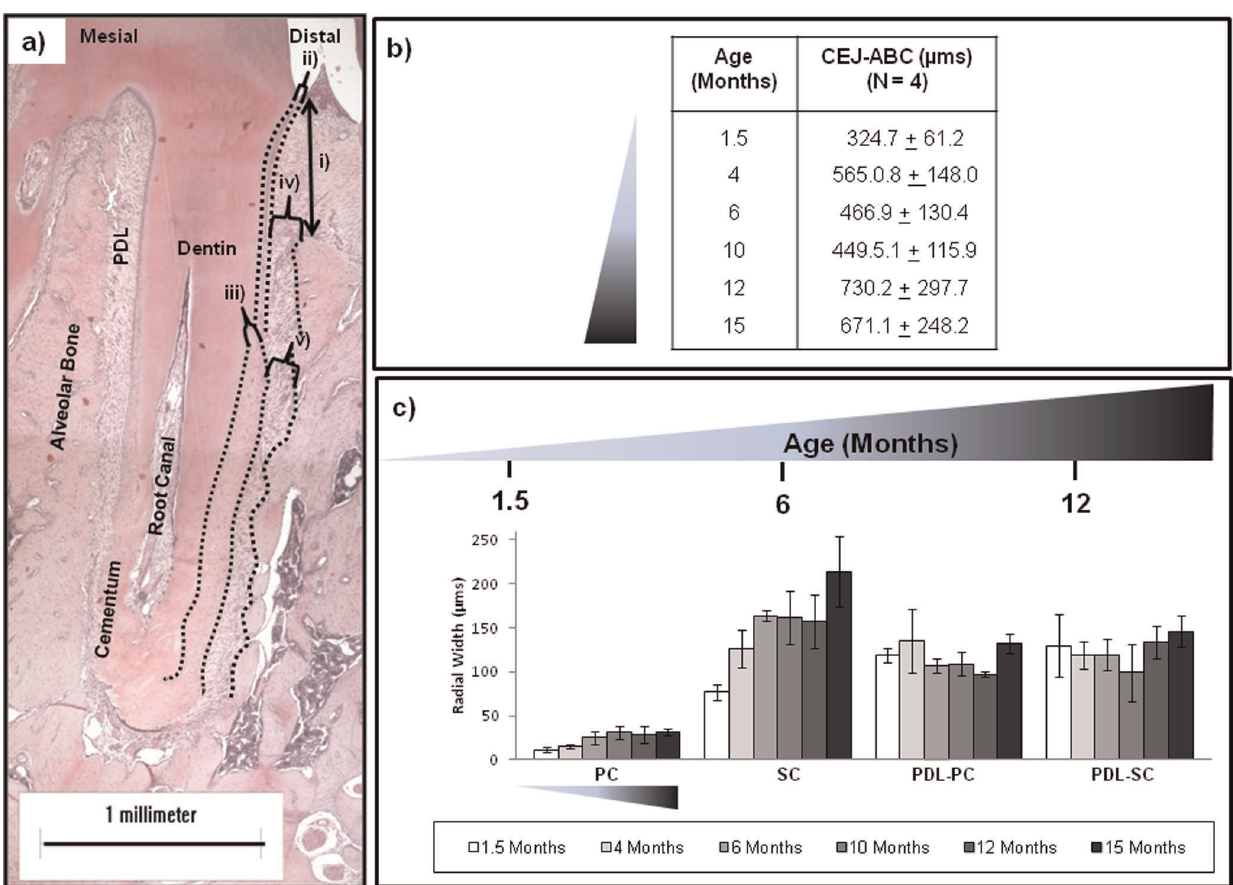
Figure 2. Histomorphometry as a function of age. a) Representative light micrograph of first molar distal root at 4X magnification illustrates histomorphometric parameters including i) CEJ-ABC distance, radial widths of: ii) primary cementum, iii) secondary cementum (SC), iv) PDL adjoining primary cementum (PDL-PC), and v) PDL adjoining secondary cementum (PDL-SC). Scale bar=1 millimeter. b) The table illustrates increasing values of CEJ-ABC distance signifying recession with age. c) Plotted histomorphometric parameters as a function of age comparatively demonstrates increasing cementum and decreasing PDL trends with age. (Fig. 4a, black arrows) with minimal stain at the distal PDL-bone